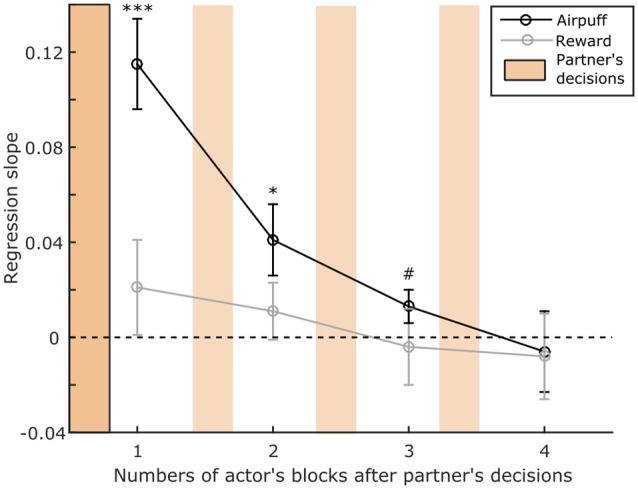
Persistence of the influence of partner’s social decisions on subsequent actor’s social decisions. We assess whether prior decisions of the partner monkey can influence the actor’s subsequent decisions in timescale longer than two consecutive blocks. The observed reciprocity when partner’s social decisions involved aipuff (p < 0.001) persists until the second actor’s block (p = 0.012). A non-significant trend can be observed on the third actor’s block (p = 0.056) but not on the fourth one (p = 0.74). We did not find any effect of partner’s social decisions involving rewards on same type of next actor’s social decisions (all p > 0.05). Y axis represents the slope of the regression (Beta coefficient of the GLME). X axis represents the number of subsequent actor’s blocks. Note that the two monkeys alternated as actor and partner on successive blocks of 30 s during which it performed an average of 3.14 (±0.9) trials. Error bars represent SE. *p < 0.05; ***p < 0.001; #p < 0.1.